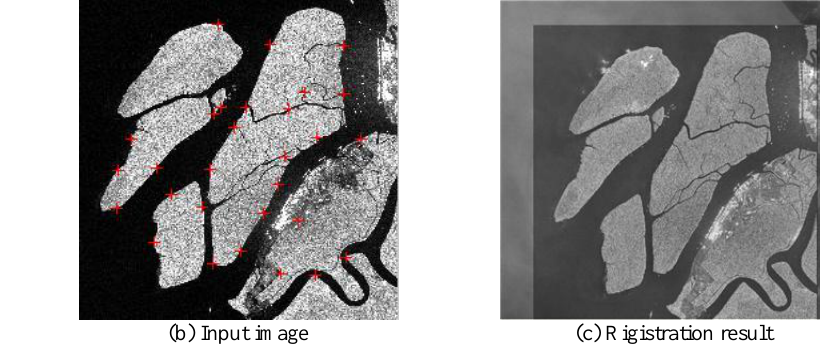
Figure 7: Image registration from test set